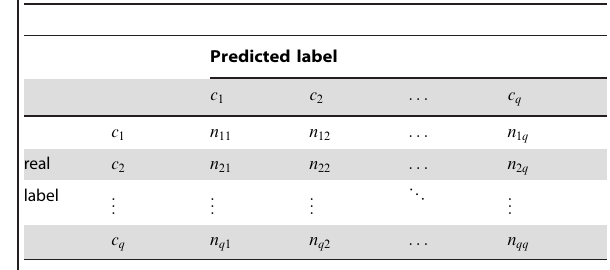
Table 1. The confusion matrix of a decision function f . n ij is the number of cases in the evaluation dataset with real label c i classified as c j